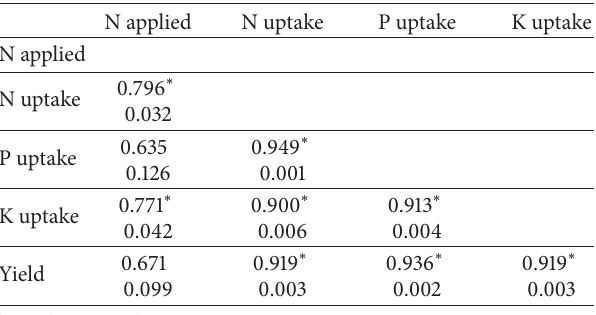
Table 11: Correlation among nitrogen fertilization, N, P, and K uptake, and grain yield.